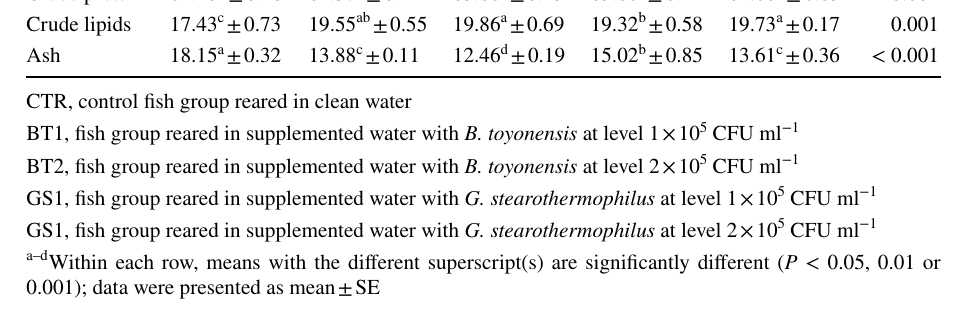
Table 4 Body chemical analysis of tilapia fish reared in treated water with or without probiotics for 70 days